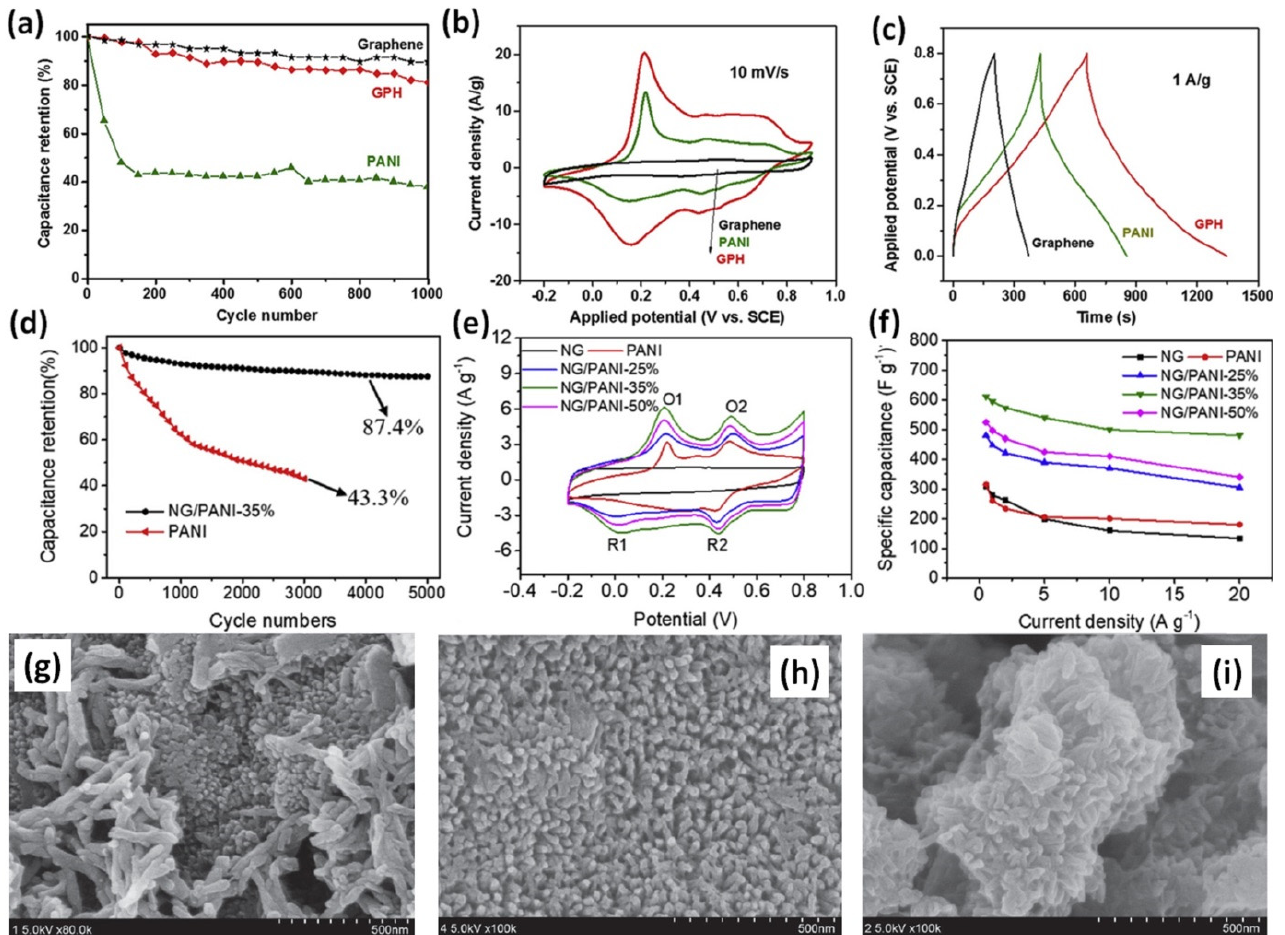
Figure 4. Cycling stabilities at 5 A/g ( a ), CV curves ( b ) and GCD curves ( c ) of graphene, PANI, and GPH at the current density of 1 A/g (Reprinted from [48], Copyright 2018, with permission from Elsevier). Capacitance retention of NG/PANI-35% and PANI electrodes after 5000 cycles at 5 A/g ( d ); CV curves of NG, pure PANI and NG/PANI electrodes with different percentage of PANI at 10 mV/s and 0.5 A/g, respectively ( e ); Specific capacitance of NG, pristine PANI and NG/PANI with different percentage of PANI at different current densities ( f ) (Reprinted from [65], Copyright 2020, with permission from Elsevier). Scanning electron microscopy (SEM) images of PAFG2 ( g ), PAFG5 ( h ) and PAFG10 ( i ) composite PANI with 2, 5 and 10 wt% amino-triazine functional reduced graphene oxide, respectively (Reprinted from [57], Copyright 2014, with permission from Elsevier).